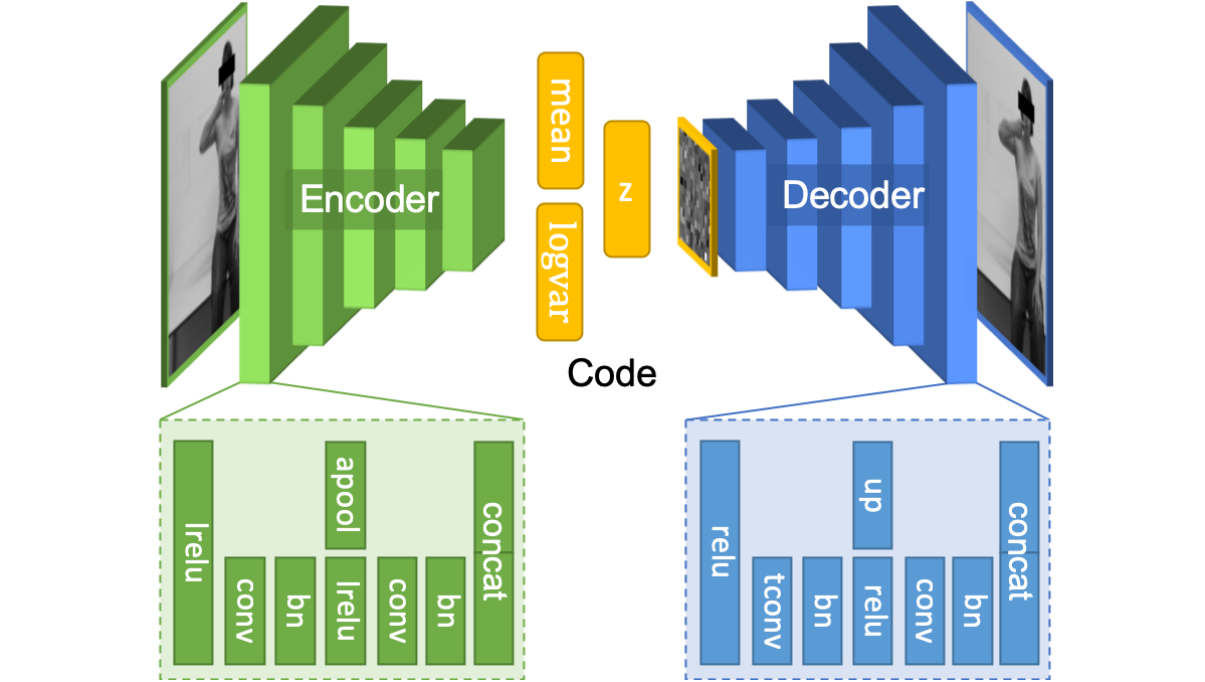
Figure 1. Structure of the variational